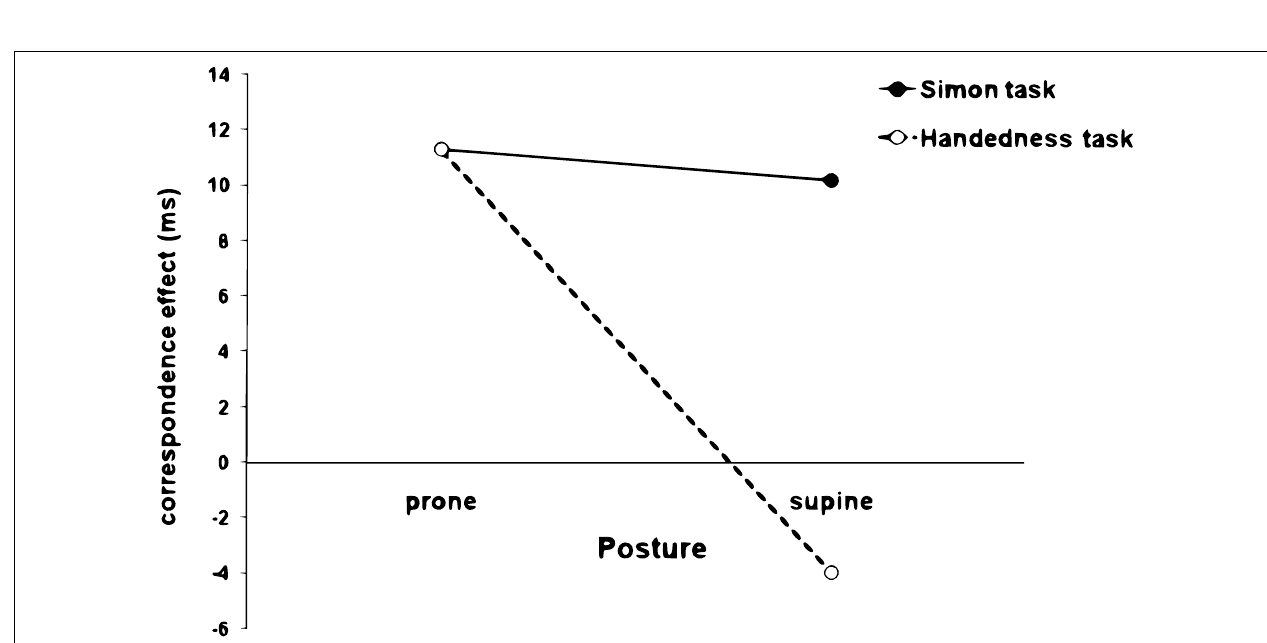
FIGURE 3 | MRT as a function of hand posture and the spatial correspondence between stimulus and response in both, Handedness task and Simon task. Notice the infl uence of the posture on S-R compatibility only in the handedness recognition. This correspondence effect disappears when the hands assumed a supine posture.